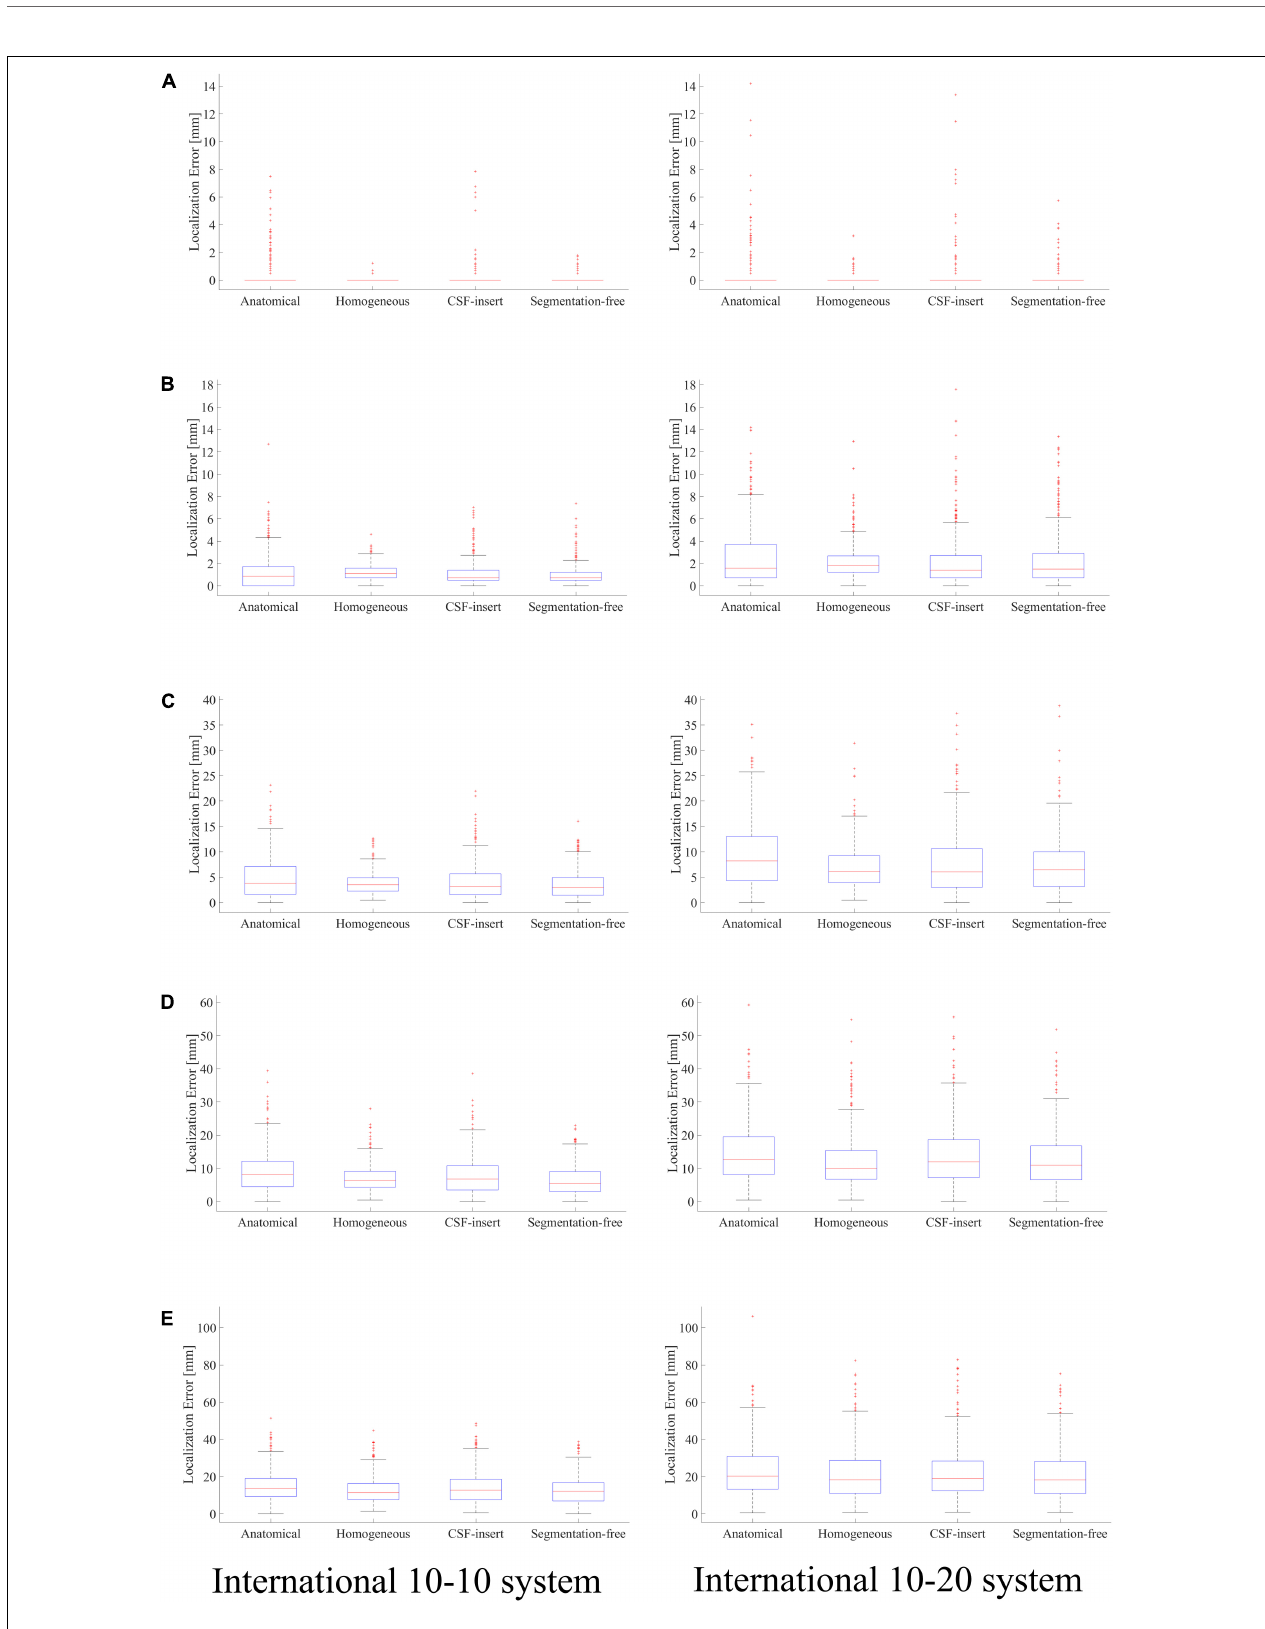
FIGURE 4 | Localization error in different head models with SNR of, (A) ∞ dB, (B) 20 dB, (C) 10 dB, (D) 5 dB, and (E) 0 dB. Boxplots are calculated from 500 patterns of selected wave sources. In the inverse problem, measured potentials, and LFM are calculated in the same model.